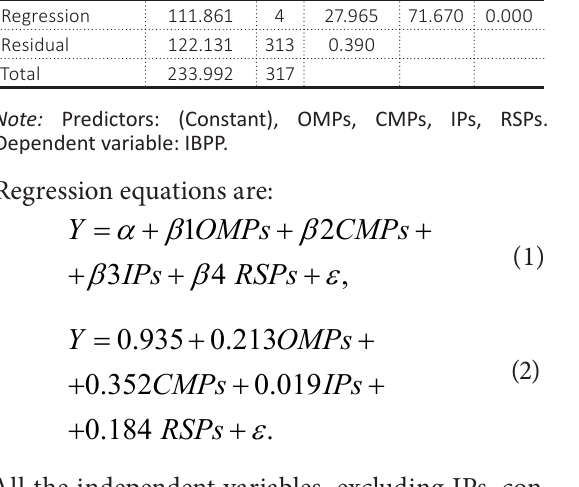
Table 4. IBPP ANOVA result Model